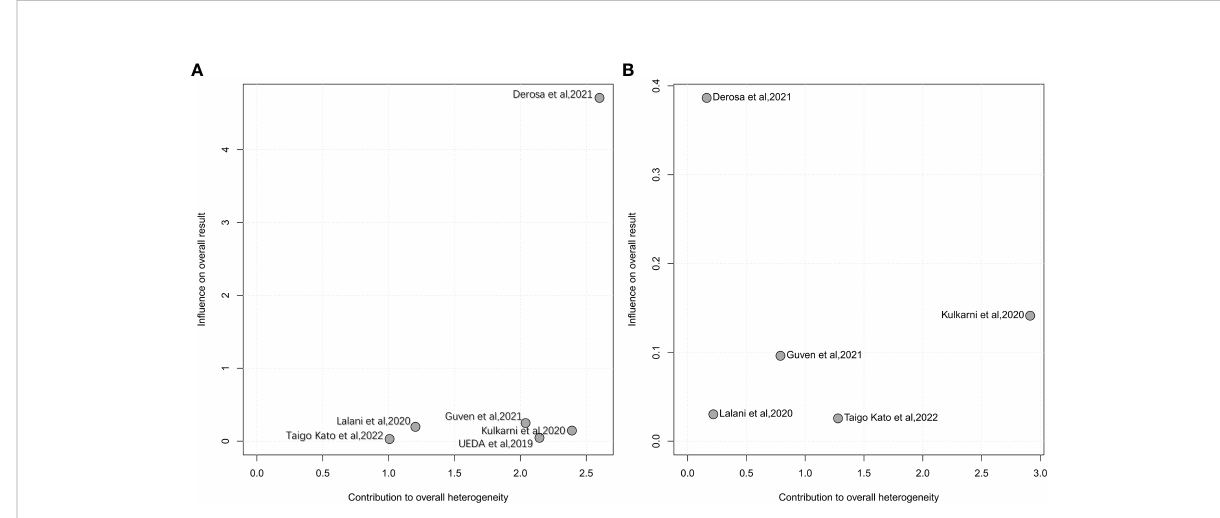
FIGURE 5 baujat plot of in fl uence analysis. A , baujat plot for PFS; B , baujat plot for